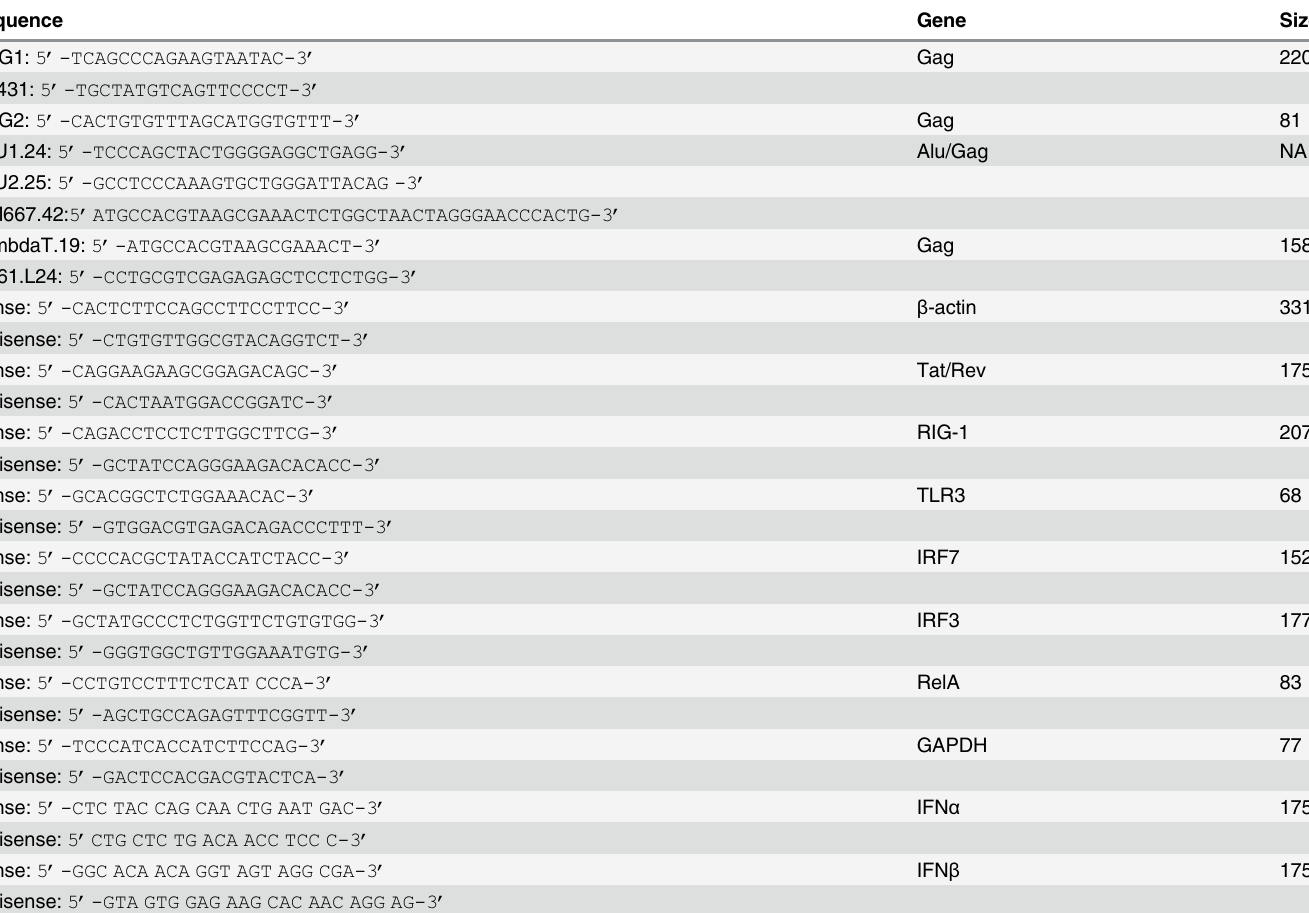
Table 1. Primer sequences to detect reverse transcribed and integrated HIV-1 DNA, as well as HIV-1 and cellular receptor, transcription factor and house keeping gene expression. Sequence Gene